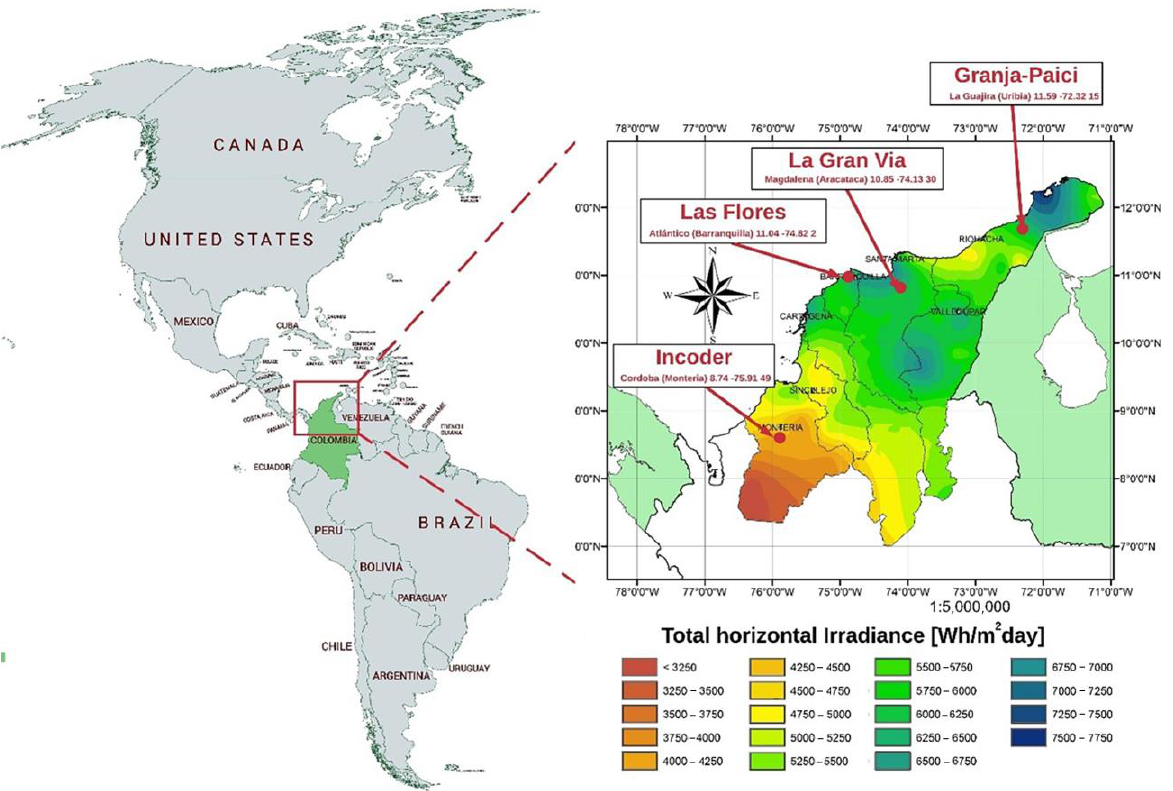
Figure 5. Location of the sites considered in the study.